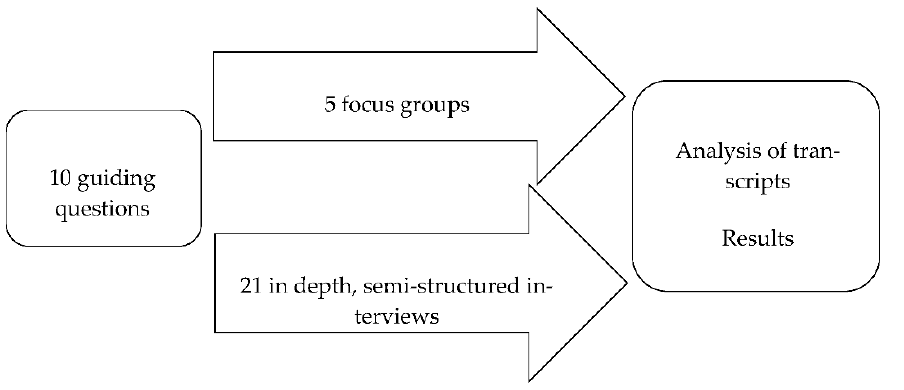
Figure 1. The two parallel phases of the study.